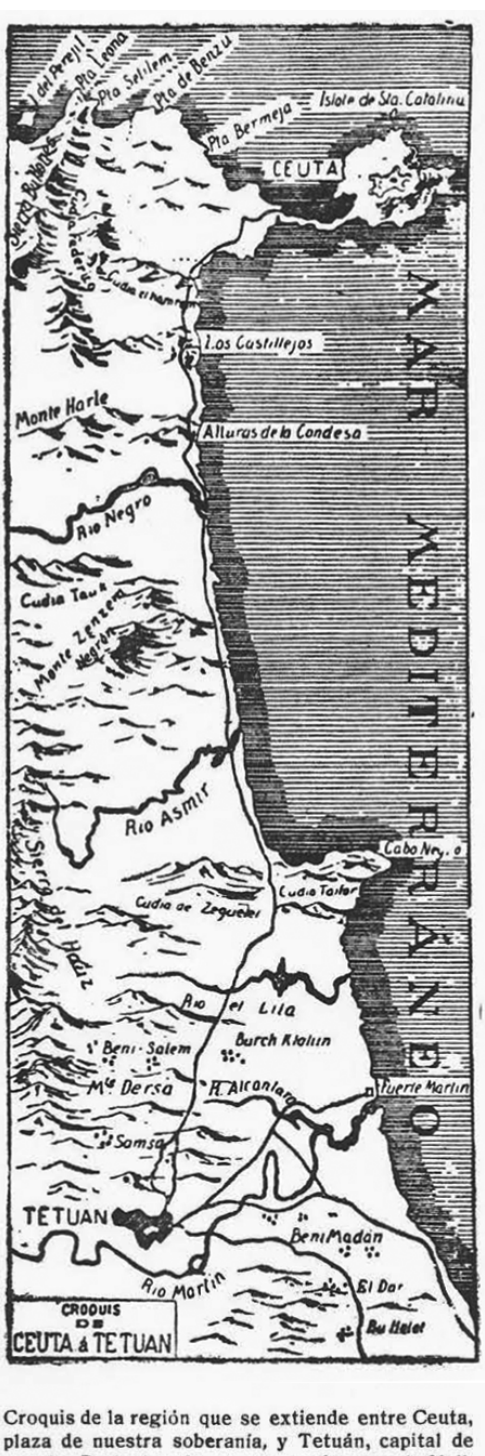
Figure 1. Map of the Grand Tetouan region. Source: Del Castillo